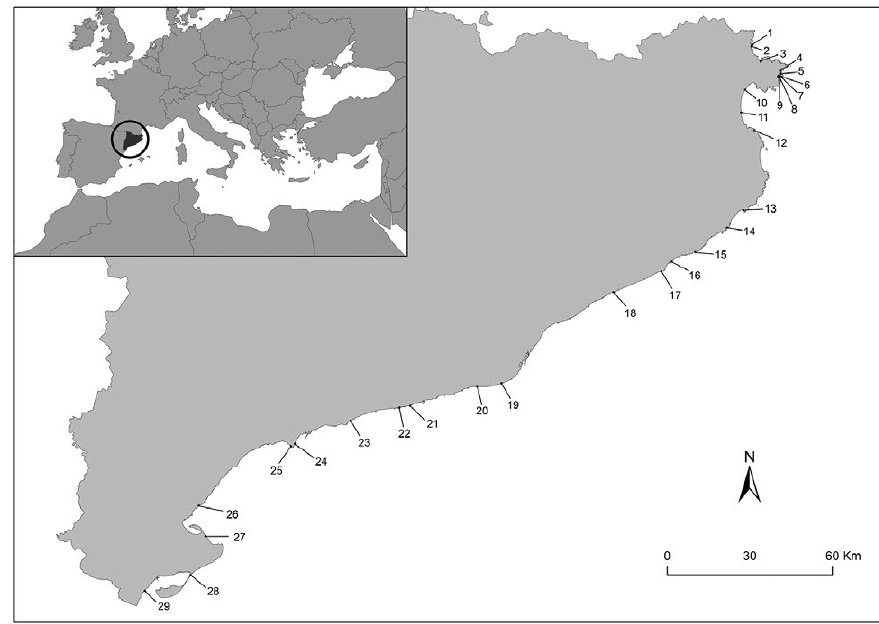
Fig. 1. – Map of the studied coastline. The position of each site is shown (see Tables 1 and 2 for details).